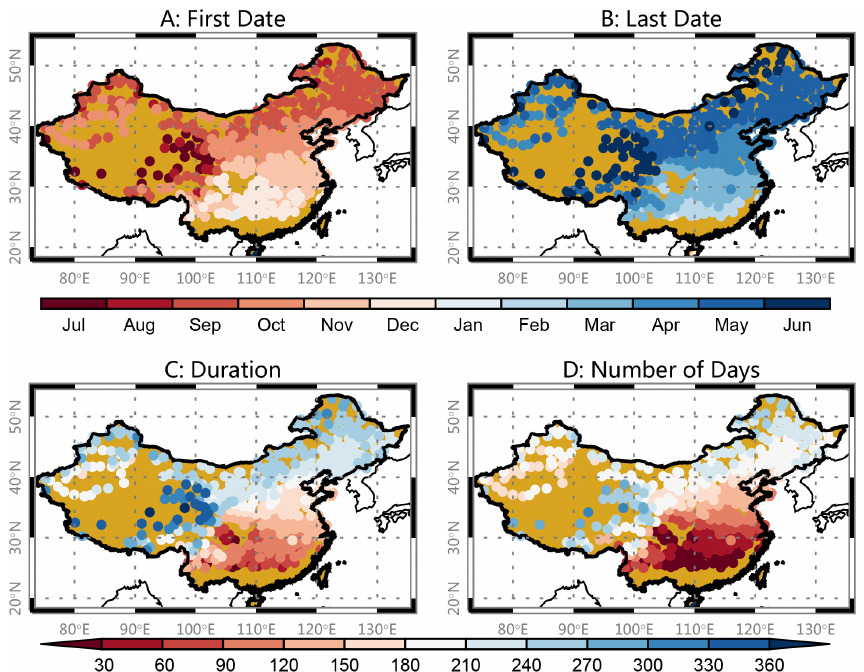
Figure 2. Climatology of the first date (a) , the last date (b) , the duration (c) and the number of days (d) of the near-surface soil freeze/thaw status across China. The 30-year reference period was from July 1961 through June